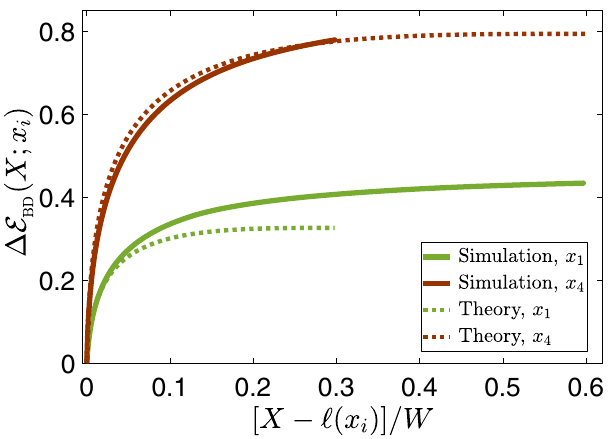
Fig. 4 Testing the theoretical predictions. Comparison of the simulational results for Δ E BD ð X ; x i Þ (solid lines, see legend), presented earlier in Fig. 3a, and the theoretical prediction Δ E BD ð X ; c r ð x i Þ ; L ¼ x i ;‘ ð x i ÞÞ (dashed lines, see legend) obtained using Eq. (1) (see text for additional details), vs. ( x i ) are given in Fig. 3b. Note that the theoretical curves, by construction, extend up to X = x i (recall that ℓ ( x i ) ≪ x i ) and that the simulational ones are limited by the fault/interface half-length W , the smaller x i the larger the maximal X